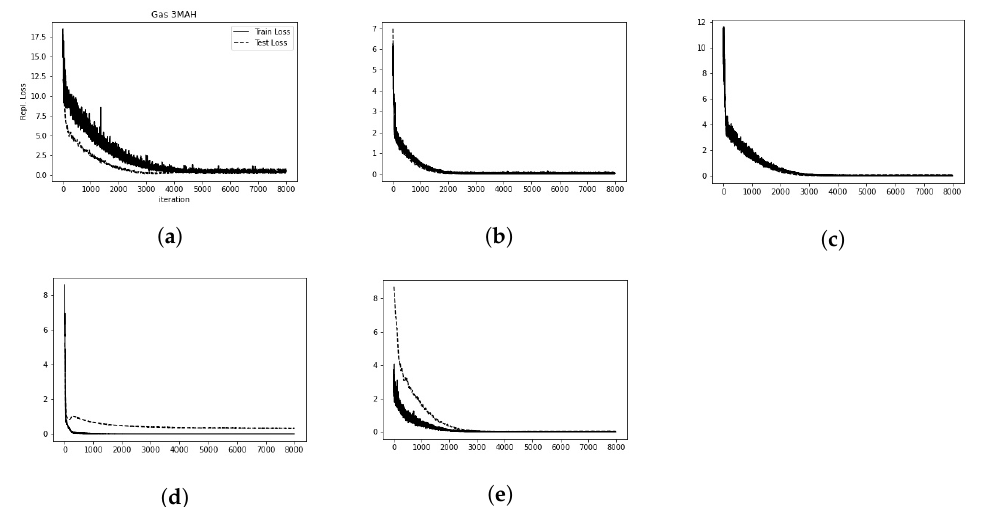
Figure A2. Losses of the deep hedgers training on the 3 MAH Gas call option. Dashed lines represent test losses computed on the historical time series; plain lines represent generator losses computed on synthetic time series. ( a ) GBM ( b ) CEGEN. ( c ) TSGAN. ( d ) COTGAN. ( e )